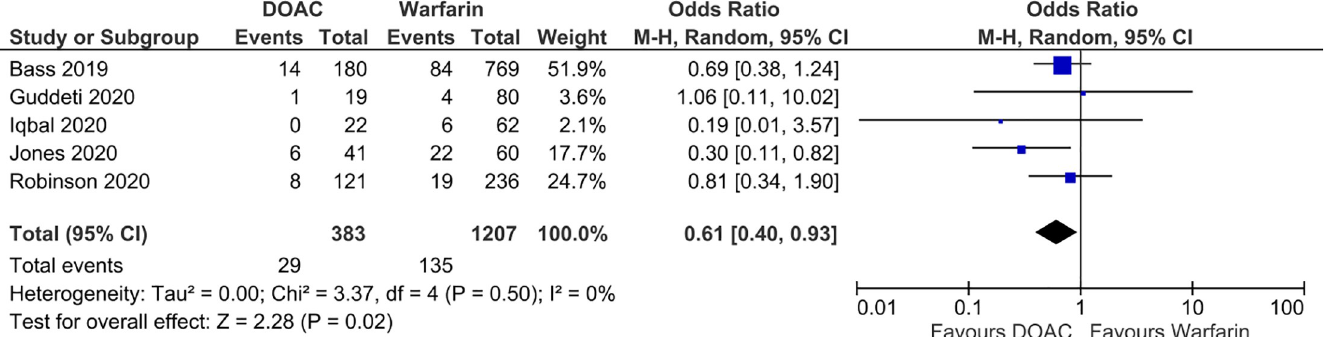
Fig 4. Forest plot of bleeding event rate in patients with left ventricular thrombus receiving DOACs versus VKA.